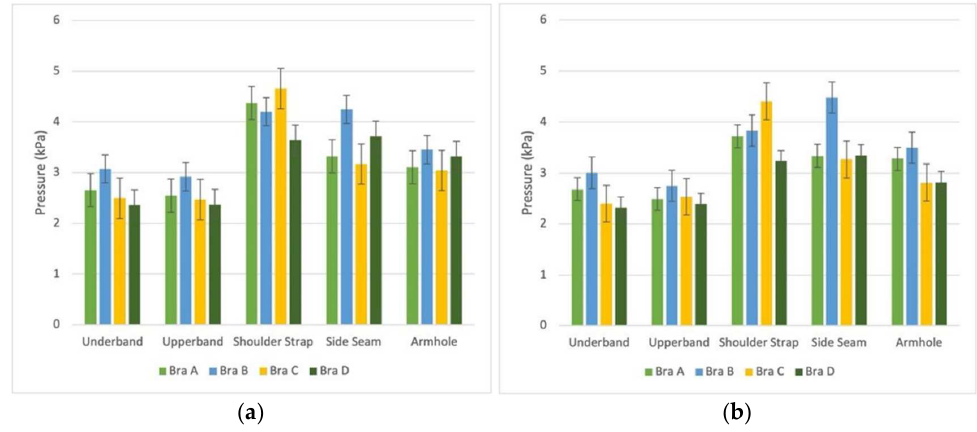
Figure 5. Pressure values at 5 locations ( a ) before treadmill exercise and ( b ) after treadmill